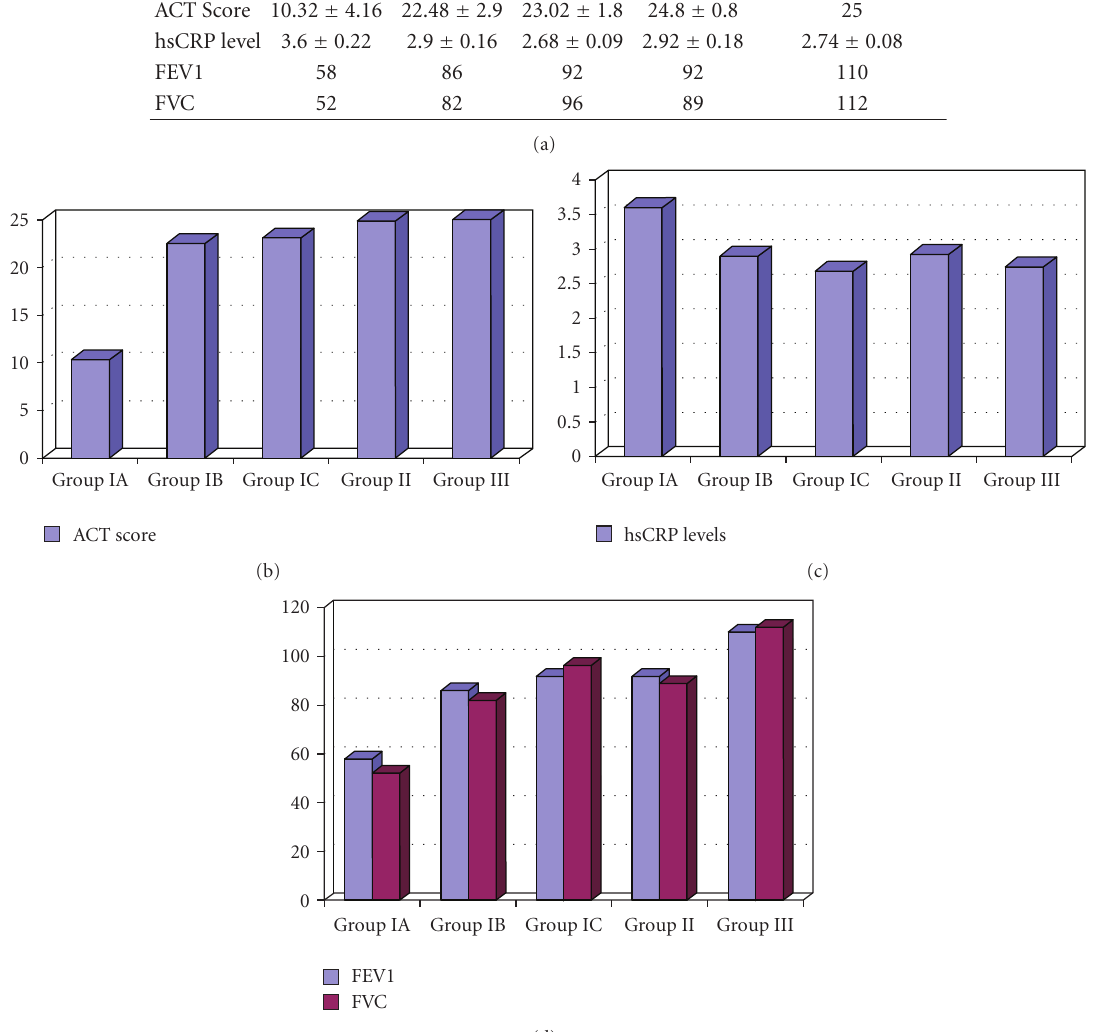
Figure 6: Clinical follow-up markers; FEV1/FVC rate, serum hsCRP levels, and ACT score of groups. ACT score was significantly increased similar to the controls after anti-IgE therapy (Group IA versus IB: P = 0 . 005). HsCRP levels were significantly decreased to the levels of controls after the treatment (Group IA versus IB: P = 0 . 04 and Group IA versus IC: P = 0 . 02). FEV1 and FVC values also significantly increased by the anti-IgE treatment depending on the time of therapy (FEV1: Group IA versus IB: P = 0 . 02 and Group IA versus IC: P = 0 . 01 and FVC: Group IA versus IB: P = 0 . 01 and Group IA versus IC: P = 0 . 008). Values are presented as mean ± standard deviation (SD). Additional bar graphs used to compare data are given.